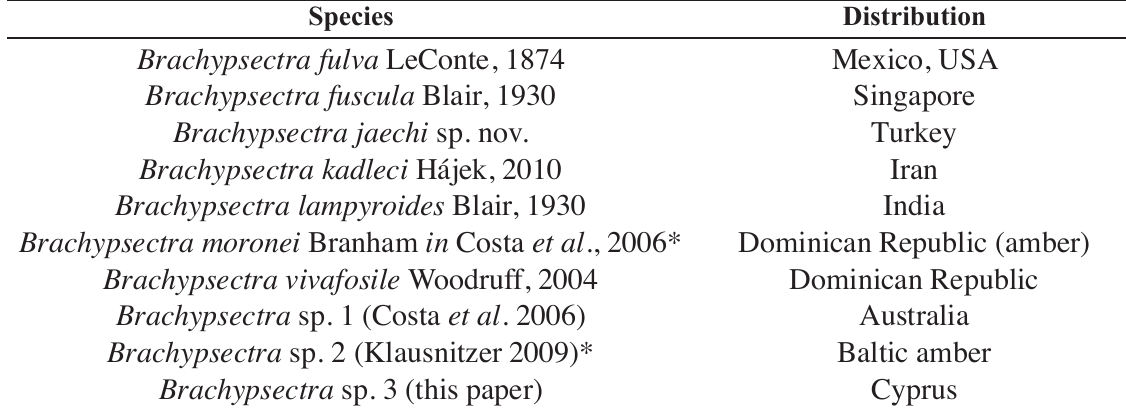
Table 1. List of species in the genus Brachypsectra LeConte. * = known only from amber fossils.